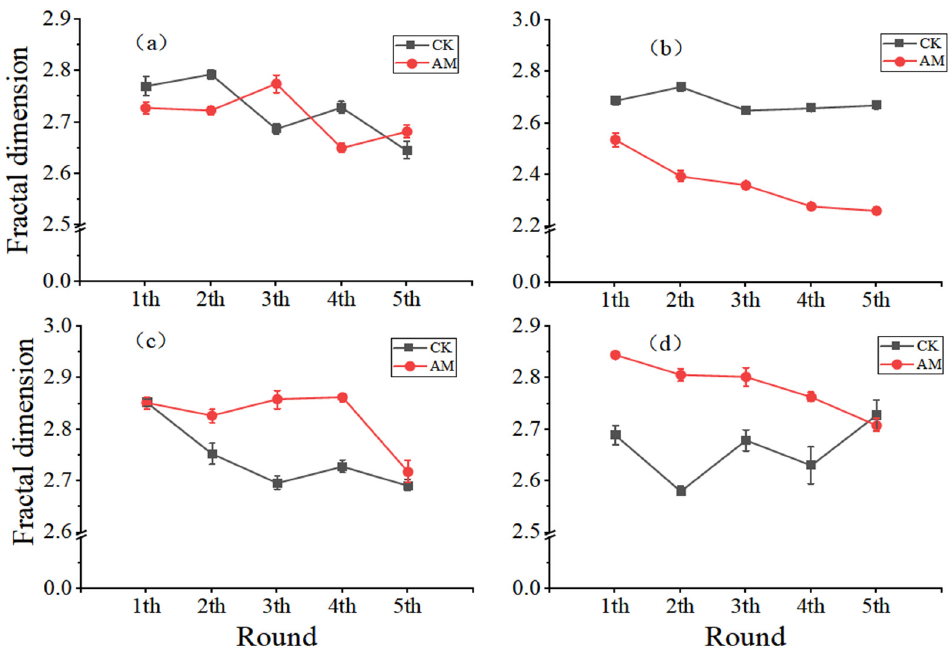
Figure 7. Variation in sediment D in different soil troughs under simulated scouring in ( a ) Cynodon dactylon , ( b ) Lotus corniculatus , ( c ) Zoysia japonica , and ( d ) Astragalus sinicus . Error bars represent ± standard errors.